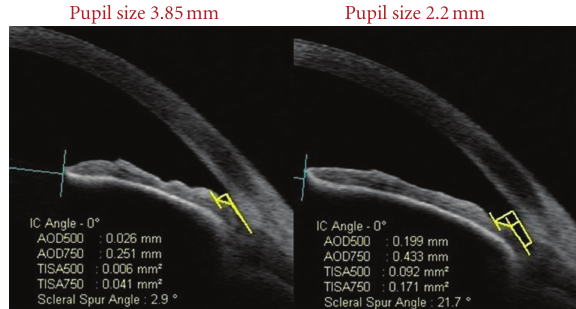
Figure 4: Influence of pupil size on angle measurements obtained with AS-OCT; the angle is more open (21 . 7 ◦ versus 2 . 9 ◦ ) with a smaller